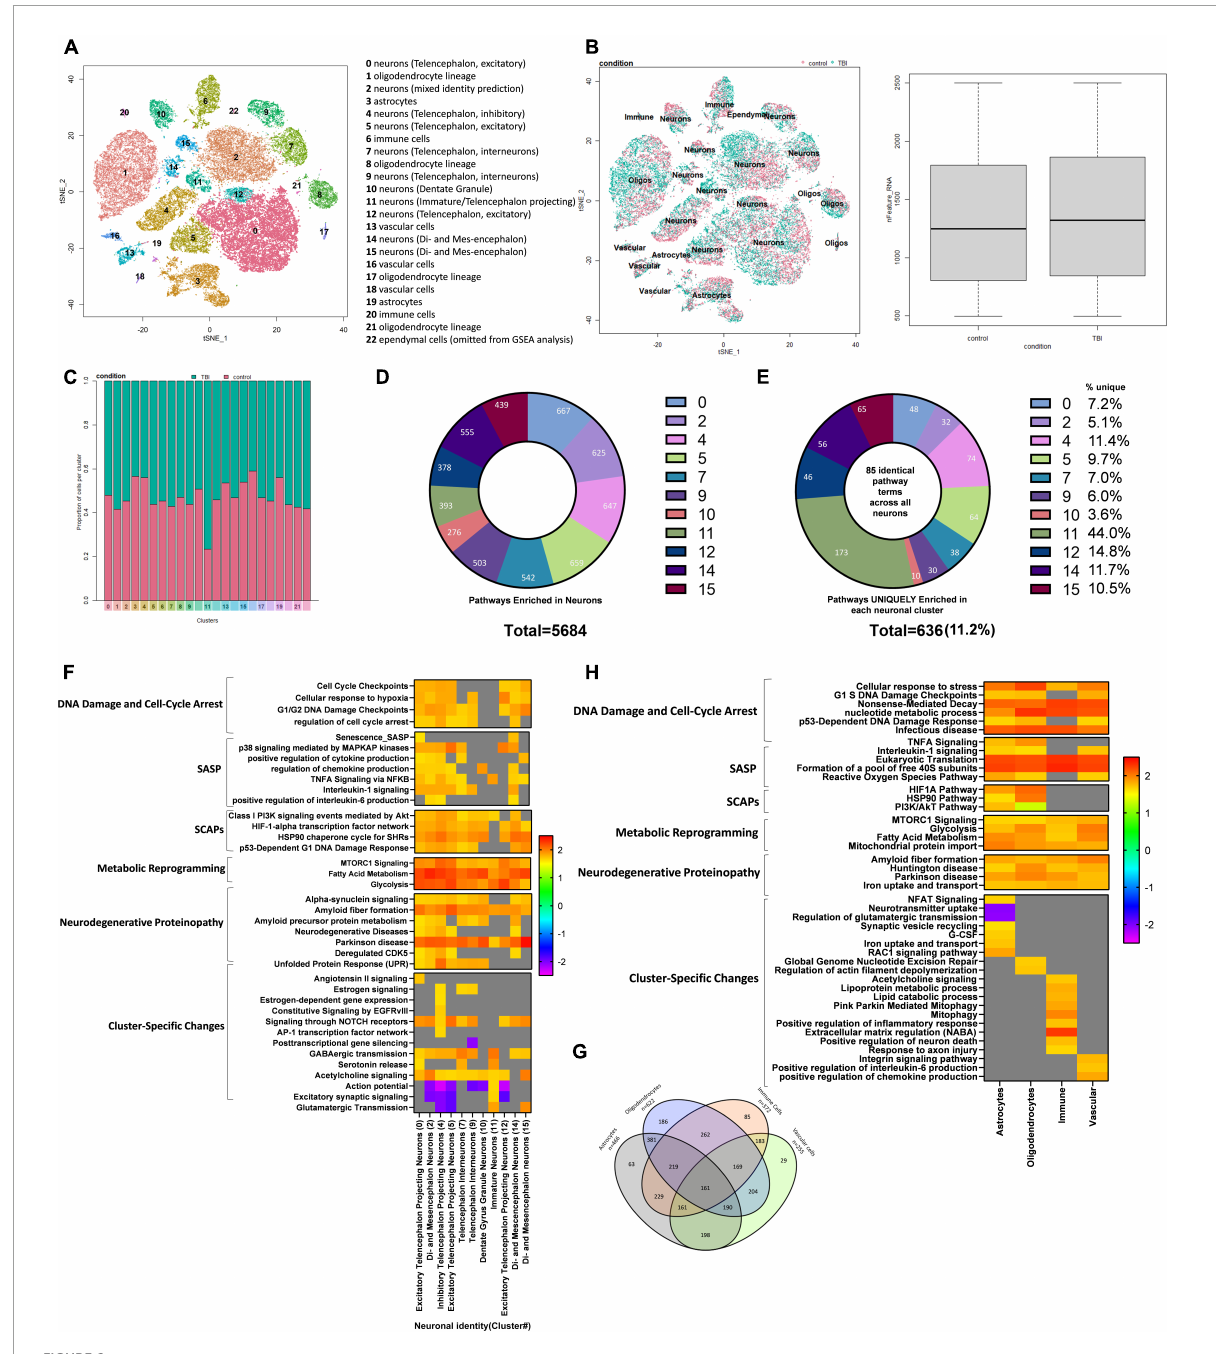
FIGURE6 Single-Cell RNA sequencing of the injured mouse brain. A total of 23 unique cell clusters were identified (A) , with similar cellular composition and RNA feature counts between shams and rmTBI mice (B,C) . In total, 5,684 pathways were significantly enriched in neuronal cell types (D) , of which 636 (11.2%) were uniquely enriched in a single cluster (E) . Gene set enrichment analysis (GSEA) revealed a senescence-like expression profile in neuronal clusters (F) including DNA damage and cell cycle control, senescence-associated inflammation, senescence-associated anti-apoptotic mechanisms, and cell specific changes with potential functional repercussions. Glial cells shared a total of 161 enriched pathways alongside unique features for each cell type (G) . GSEA revealed a similar expression profile in glial cells to neurons, indicating senescence and cell-specific functional changes (H)